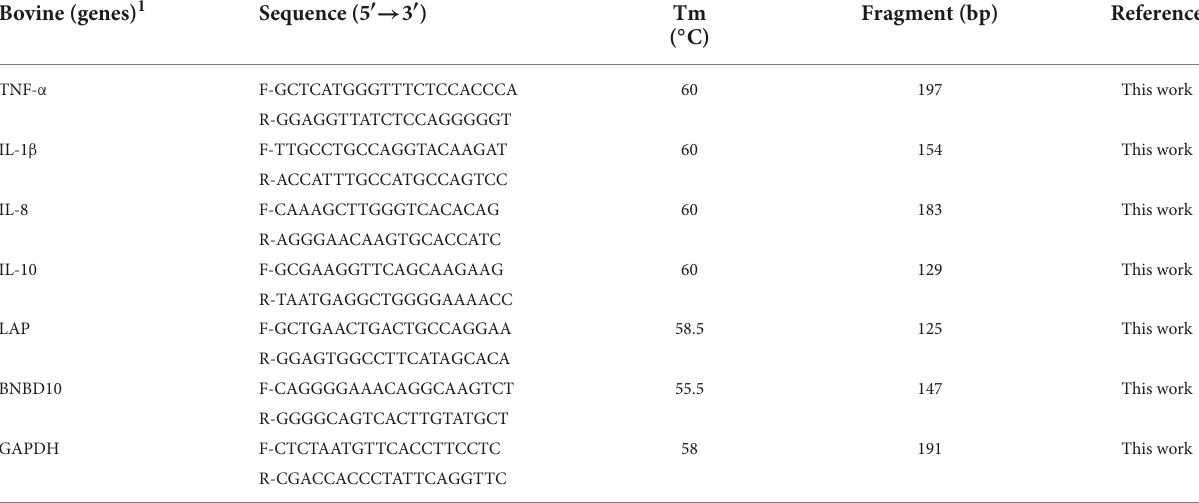
TABLE 1 Primers used for the analysis of the promoter region of innate immune response genes. Bovine (genes) 1 Sequence (5 (cid:48) → 3 (cid:48) )